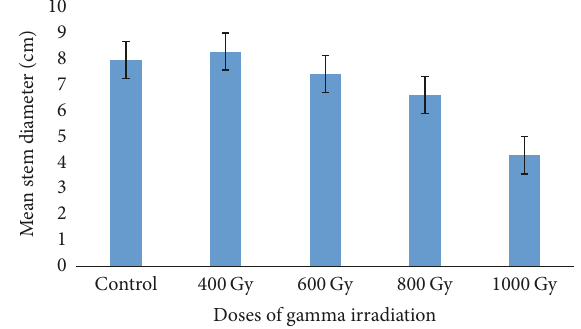
Figure 6: The effect of gamma irradiation doses on mean stem diameter.